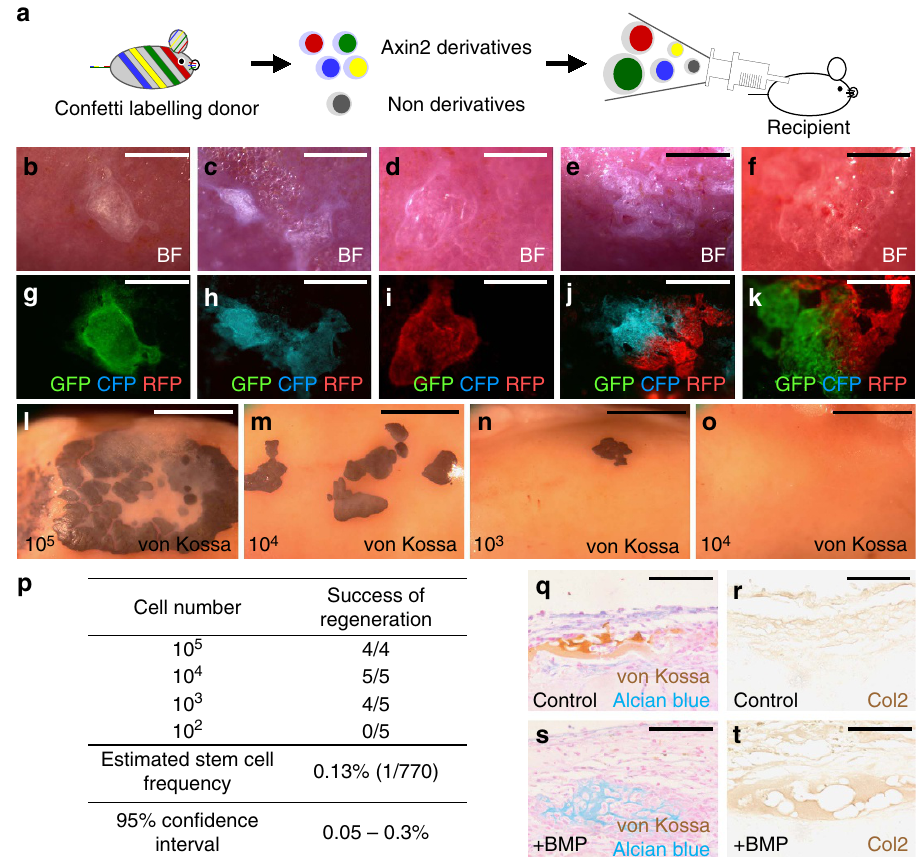
Figure 6 | Bone regeneration examines the clonal expansion, stem cell frequency and multipotency of SuSCs in vivo . ( a ) Diagrams illustrate our strategies to examine stem cell characteristics of the Axin2-expressing cells at a single-cell level using Axin2 Cre-Dox ; R26RConfetti . Ectopic bone formation is assessed by gross evaluation ( b – f ), fluorescent imaging ( g – k ), von Kossa staining ( l – o ) in whole mounts. Limiting dilution analysis shows the success of bone regeneration with transplantation of 10 5 , 10 4 and 10 3 , but not 10 2 cells ( l – o ), providing a quantitative assessment for the stem cell frequency using ELDA software ( p ). The transplanted suture cells with ( s – t ) or without ( q – r ) addition of BMP2 were analyzed by double labelling of von Kossa and alcian blue ( q , s ) and immunostaining of type II collagen ( r , t ). Images are representatives of three ( b – k , q – t ), four ( l ) and five ( m – o ) independent